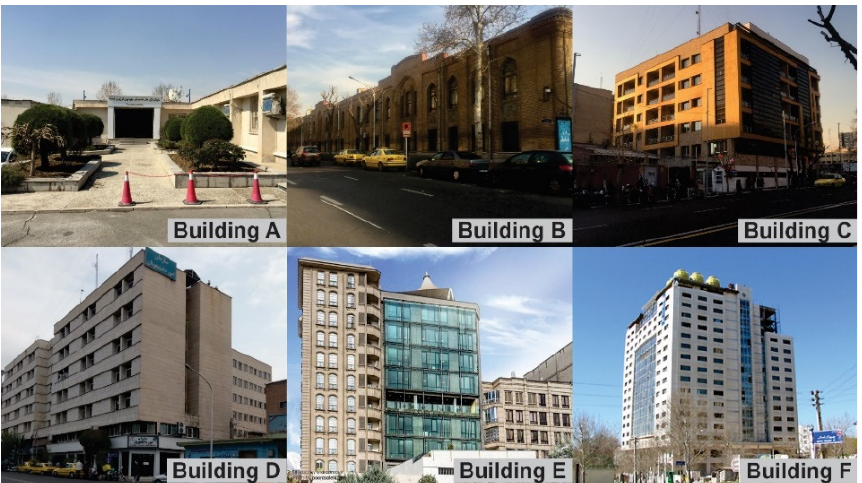
Figure 1. Studied buildings. ( A ) Power Research Center ( B ) Administrative office of the University of Art ( C ) The municipality building ( D ) Student Affairs Organization Building ( E ) Kayson INC. ( F ) The Ministry of Science, Research and Technology.